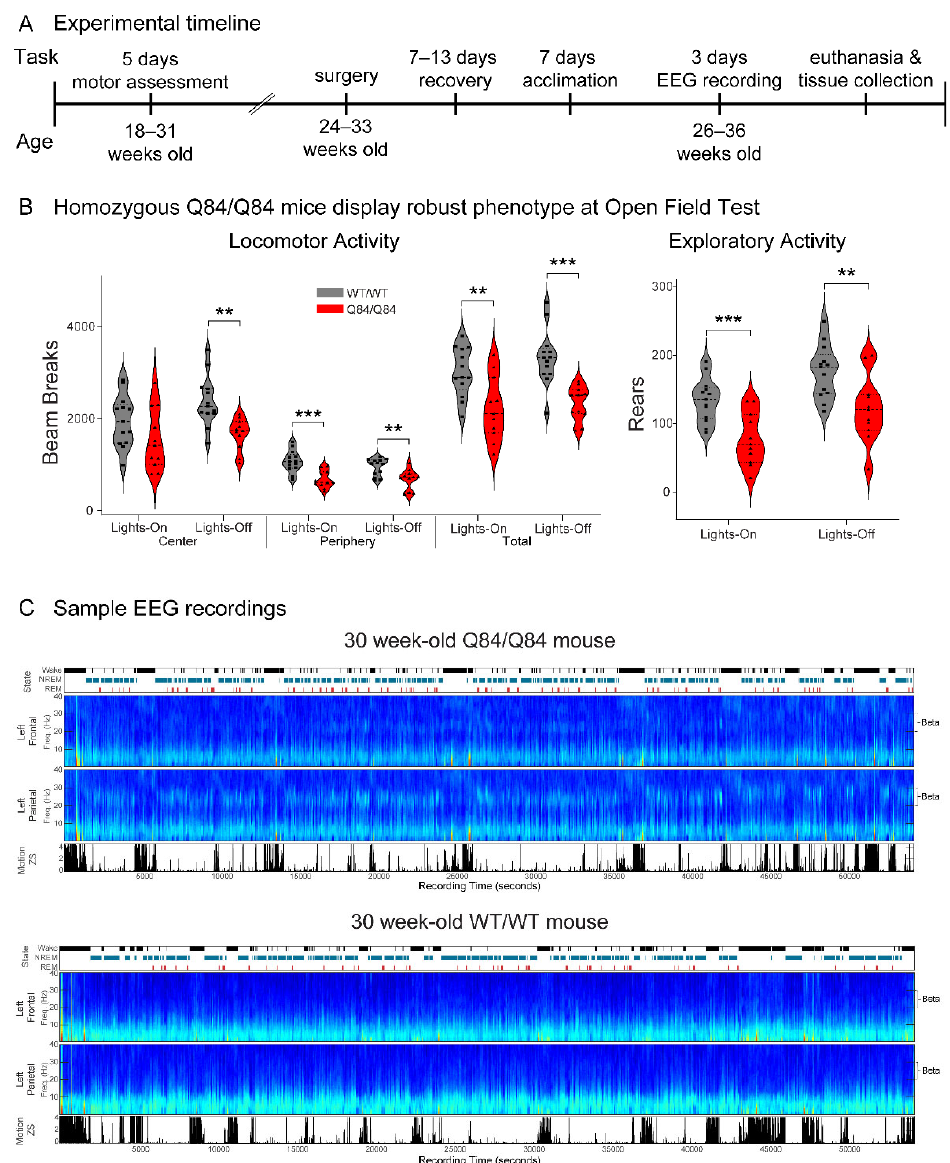
Figure 1. Measurement of motor behavior and sleep in SCA3 Q84 mice. ( A ) The motor behavior of 18–31 ‐ week ‐ old mice was assessed in the morning with the lights on and in the evening with the lights off for five consecutive days. Next, mice underwent surgery to implant the recording